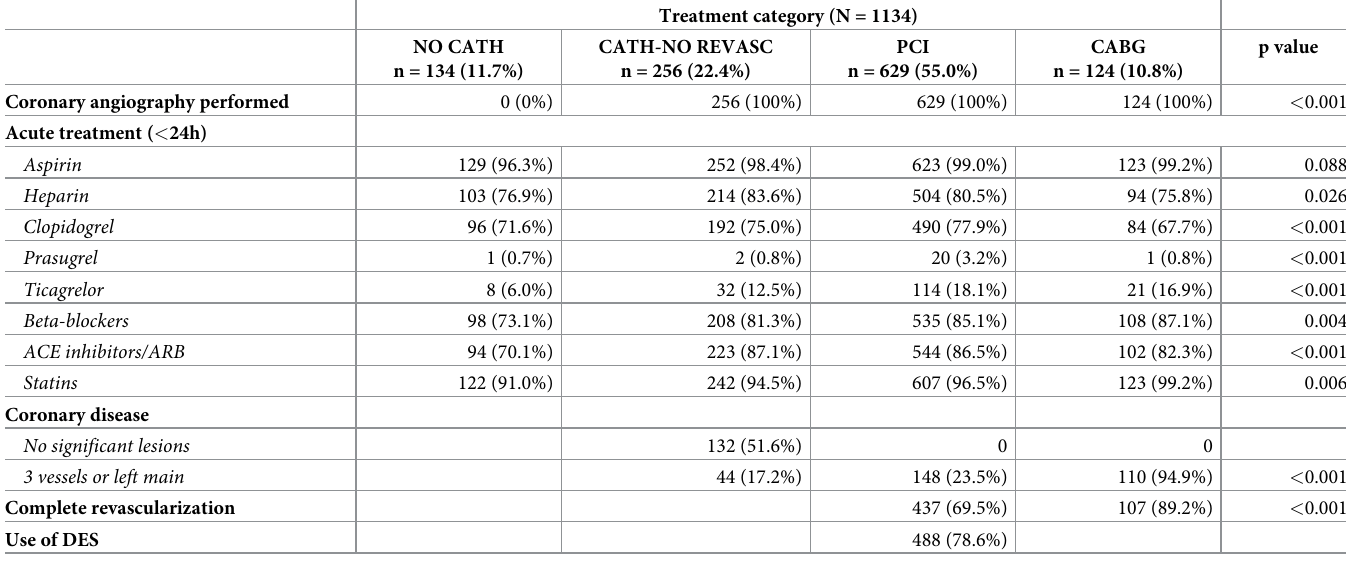
Table 2. Management during admission.